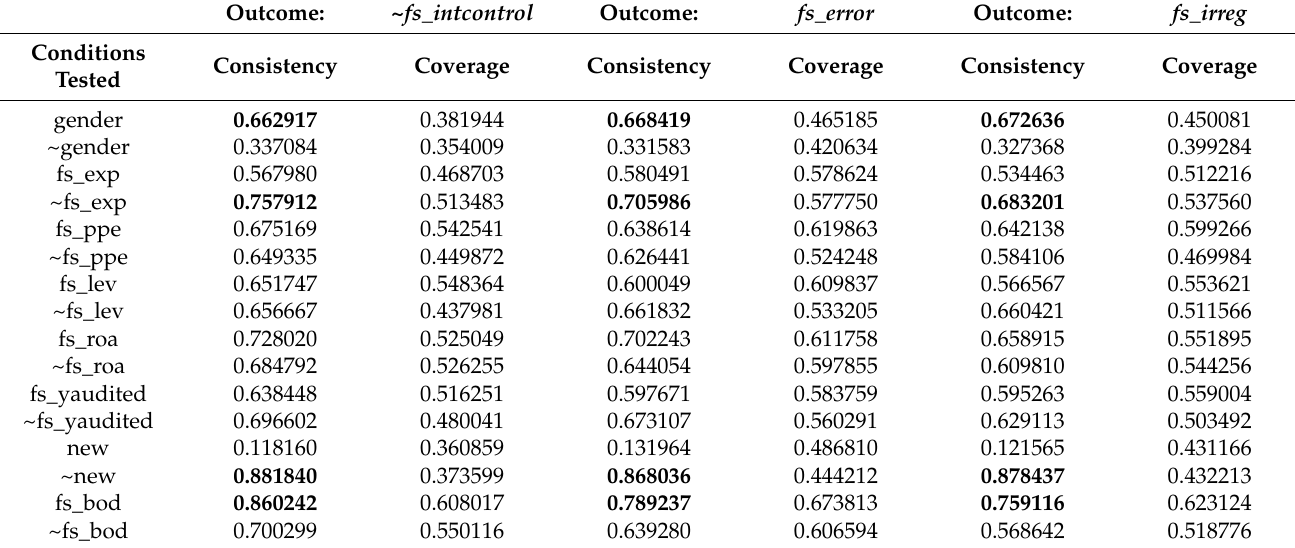
Table 5. Analysis of necessity for the absence of internal control and for the presence of expected errors and